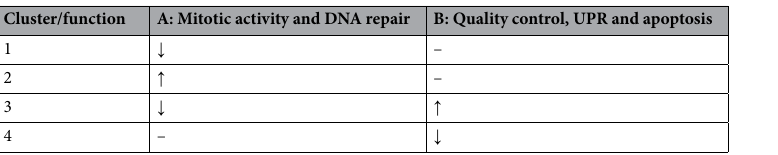
Table 3. Function groups and their activity in each cluster. Abbreviations: ↓ minimum activity; ↑ maximum activity; – baseline or reference activity; UPR, unfolded protein